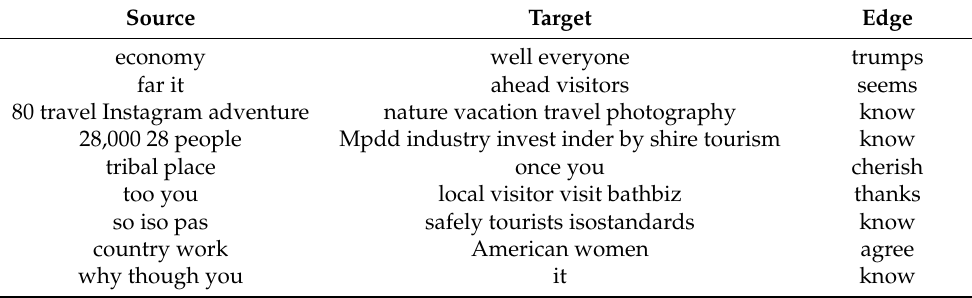
Table 9. Cluster wise Entity Relation Extraction–4.